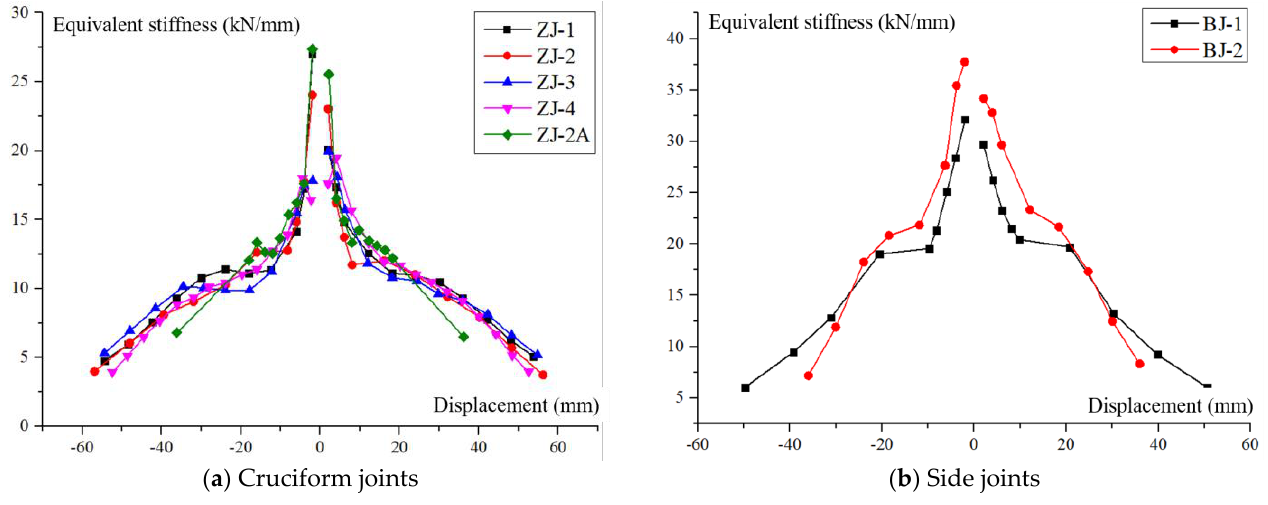
Figure 23. Stiffness degradation curves of specimen.